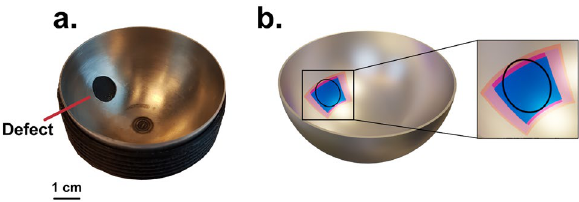
Figure 3. Comparison of a sample featuring a cavity ( a ) and the 3D model showing the localized defect ( b ). The blue and red regions indicate the size and location of a 9.5 mm defect predicted by the FEM simulations and the experimental results respectively. The translucent blue and red regions highlight the confidence limits of the defect size obtained from the simulations and the experiments respectively. The small mismatch in the polar direction might have been caused by a small offset produced when drilling the